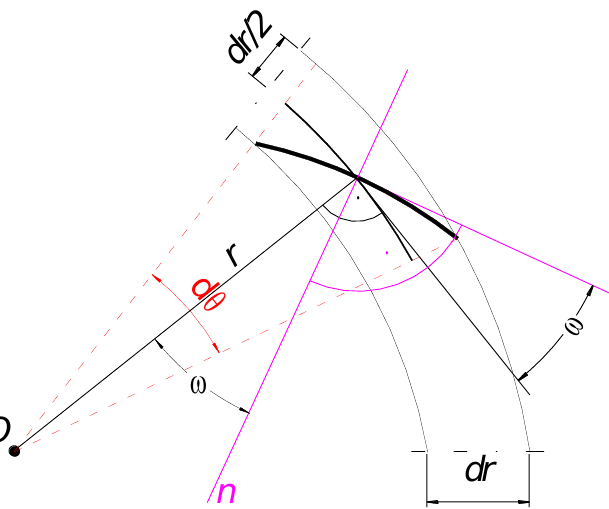
Figure 2. The central cross section of the infinitesimal surface area ( dA ) marked with the thickest line, whereas the circle at radius r is marked with the thicker line.